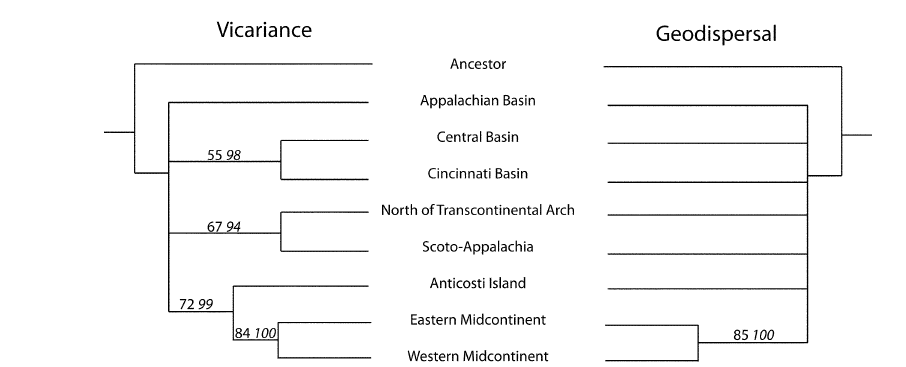
Fig. 3. Vicariance and geodispersal general area cladograms. The vicariance tree indicates the relative order that areas became separated from each other due to barrier formation (intracratonic arch, water mass changes, etc.). The geodispersal tree indicates the relative order in which regions were joined. Congruence between tree topologies indicates that geographic barriers rose and fell in the same relative order, indicating the importance of cyclical geologic processes (e.g. oscillating sea levels), whereas incongruence indicates that singular events (e.g. tectonic pulses) were more influential in biogeographic evolution of the clades (Lieberman 2000). The vicariance area cladogram is the strict consensus of two most parsimonious trees (length of 103 steps, retention index (RI) 0.515, consistency index (CI) 0.845) and the dispersal area cladogram is the strict consensus of eleven most parsimonious trees (91 steps, RI 0.500, CI 0.923). Numerical values indicate bootstrap (plain text) and jackknife (italicized) support for the